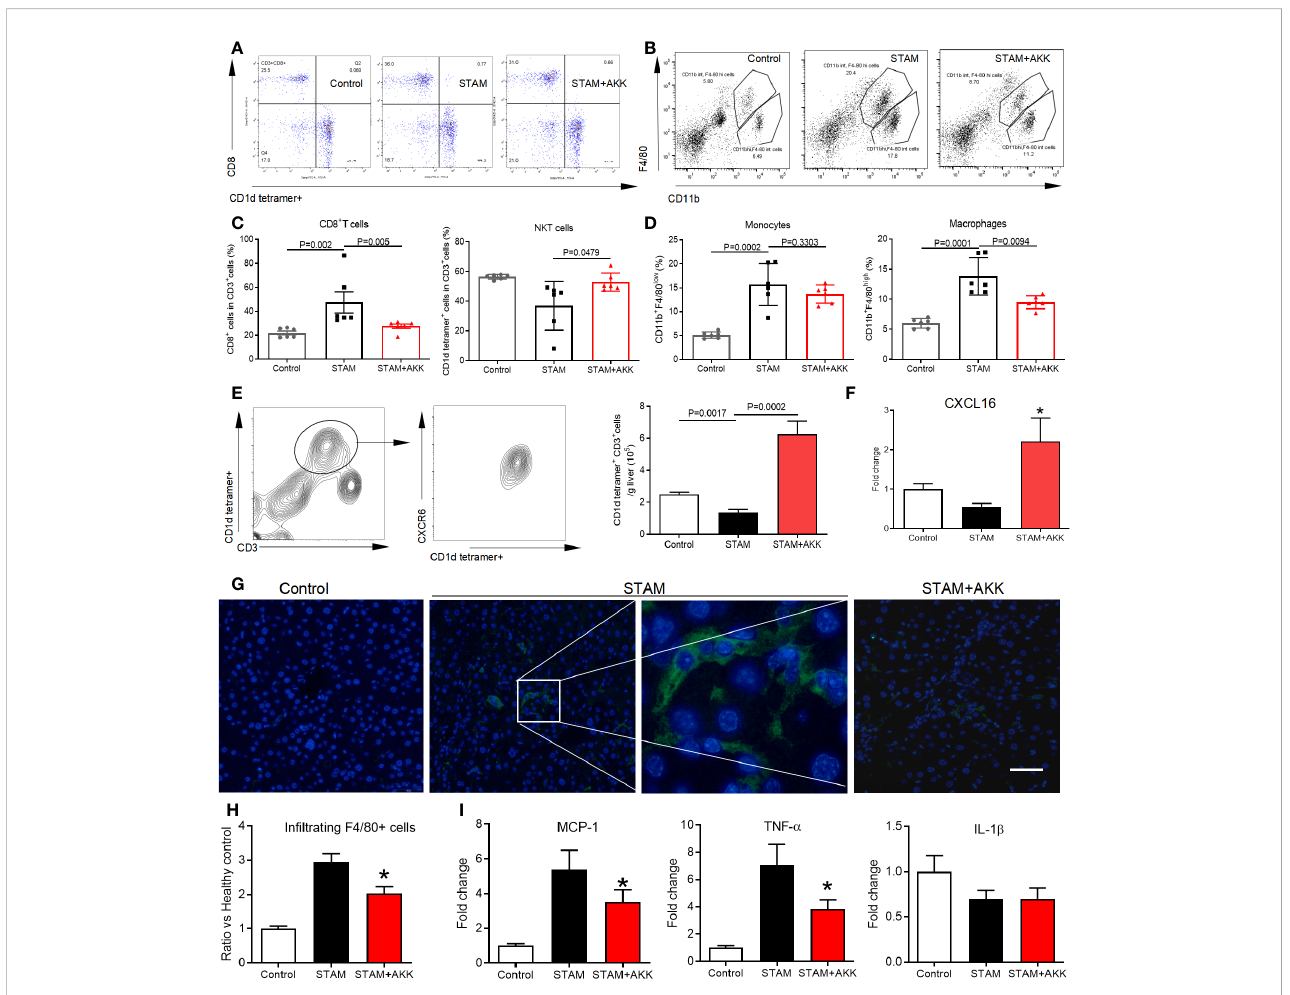
FIGURE 5 A muciniphila increases NKT cell but reduces macrophage in fi ltration and in fl ammatory cytokines in the livers of STAM. (A) Quanti fi cation of subgroups of T cells and (B) macrophages by fl ow cytometry. The percent of (C) CD8 + T cells, NKT cells, (D) monocytes and macrophages in the liver were evaluated. (E) Representative CXCR6 staining in hepatic NKT cells from three independent experiments. Relative mRNA levels of (F) CXCL16 in the liver were determined by real-time PCR and normalized to GAPDH. Data represent mean ± SEM of two pooled experiments (n=6/group). (G) Immuno fl uorescent staining for macrophages (Scale bars, 50 µm). (H) The in fi ltration macrophages in the liver were counted (vs healthy control group). (I) Relative mRNA levels of MCP-1, TNF- a and IL-1 b in the liver were determined by real-time PCR and normalized to GAPDH. Data represent mean ± SEM of two pooled experiments (n=6/group). AKK, Akkermansia muciniphila . MCP-1, monocyte chemoattractant protein-1. *P<0.05 vs STAM group by unpaired Student ’ s t